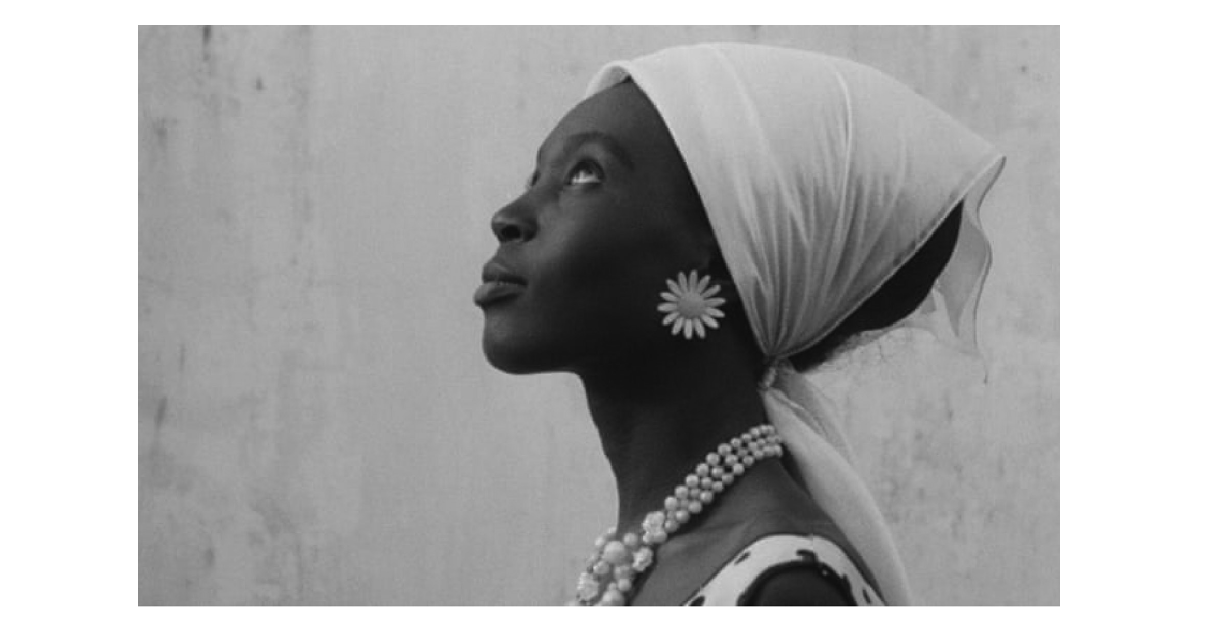
Figure 2. Still from Black Girl (Ousmane Sembene,